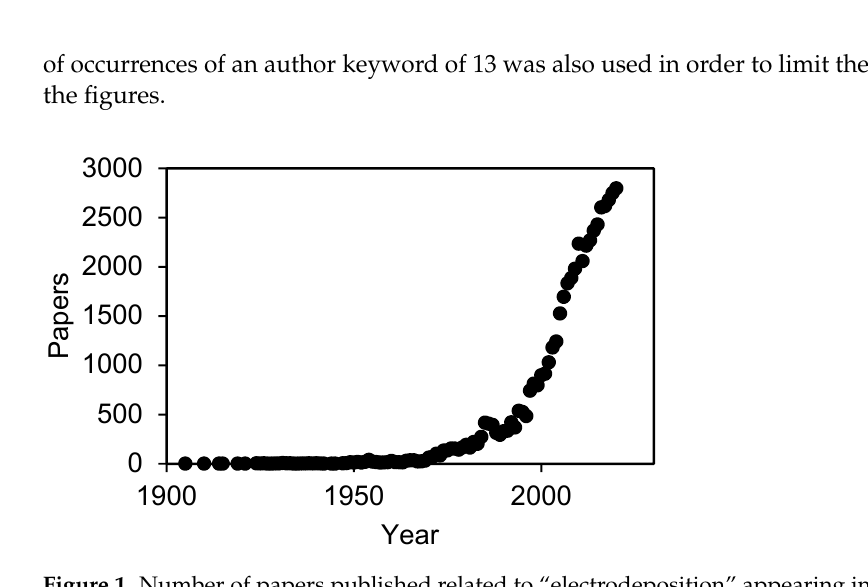
Figure 1. Number of papers published related to “electrodeposition” appearing in either abstract,